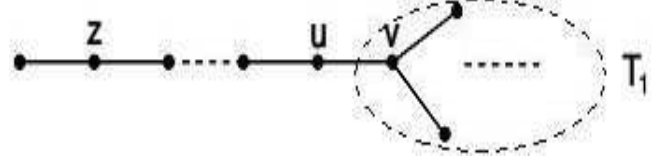
Containing a Subtree T n